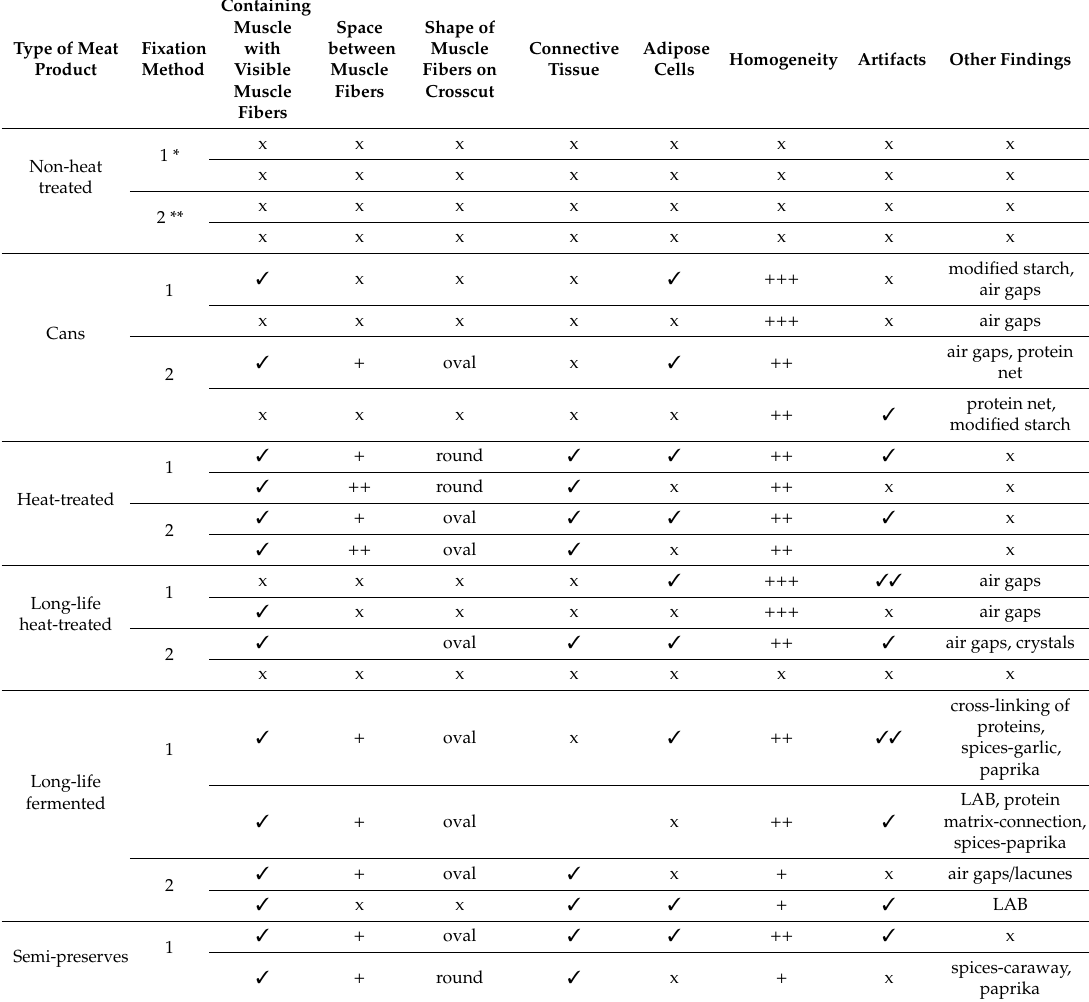
Table 2. Evaluation of the